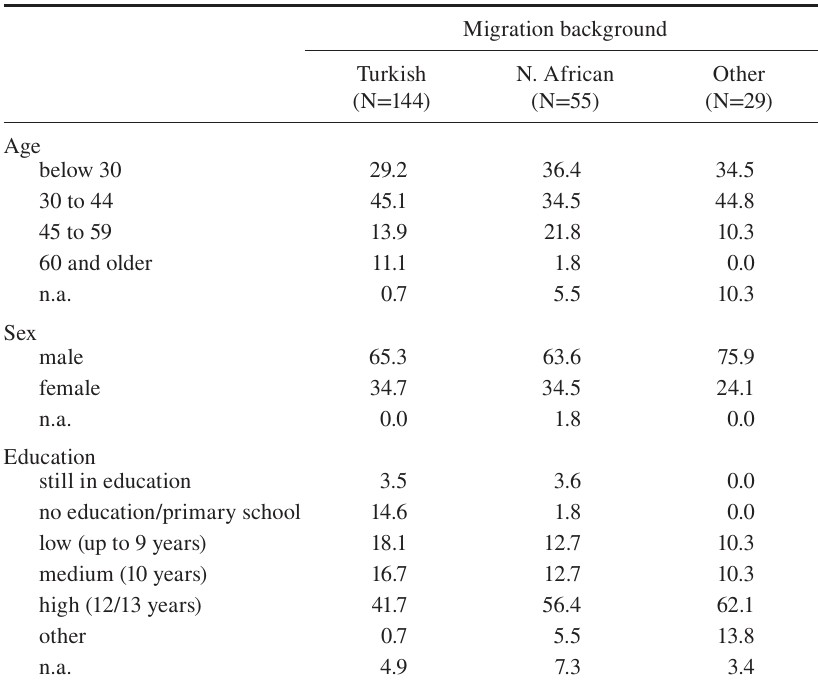
Table 1 : Demographic characteristics of the sample (N=228)